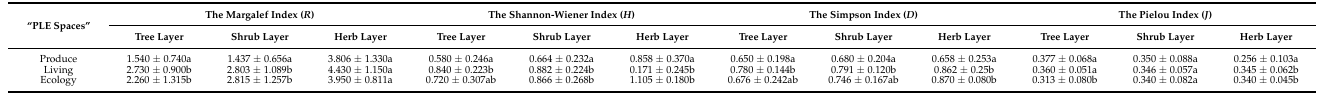
Table 10. Species diversity index of plant community in “production-living-ecological”